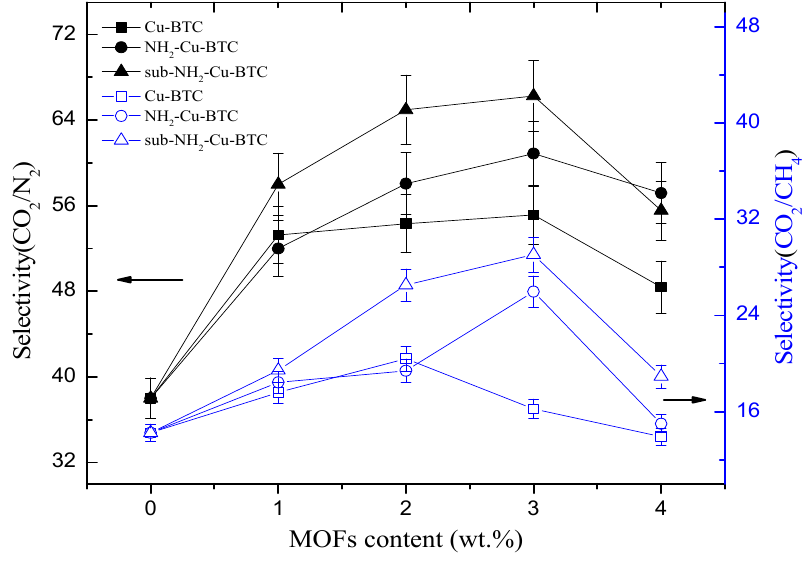
Figure 9. Effects of MOFs loading level on the gas separation selectivity.